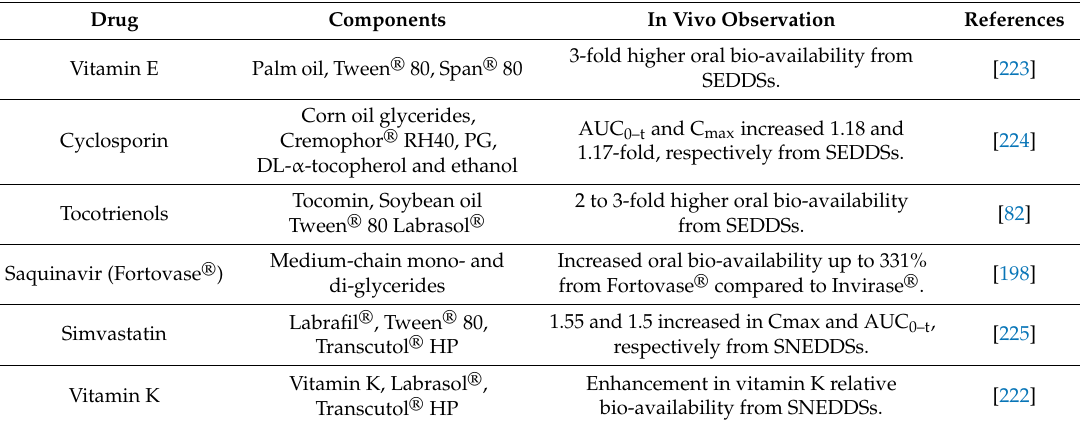
Table 4. Pharmacokinetics data reporting enhanced bio-availability from Self-Emulsifying Drug Delivery Systems (SEDDS) in human